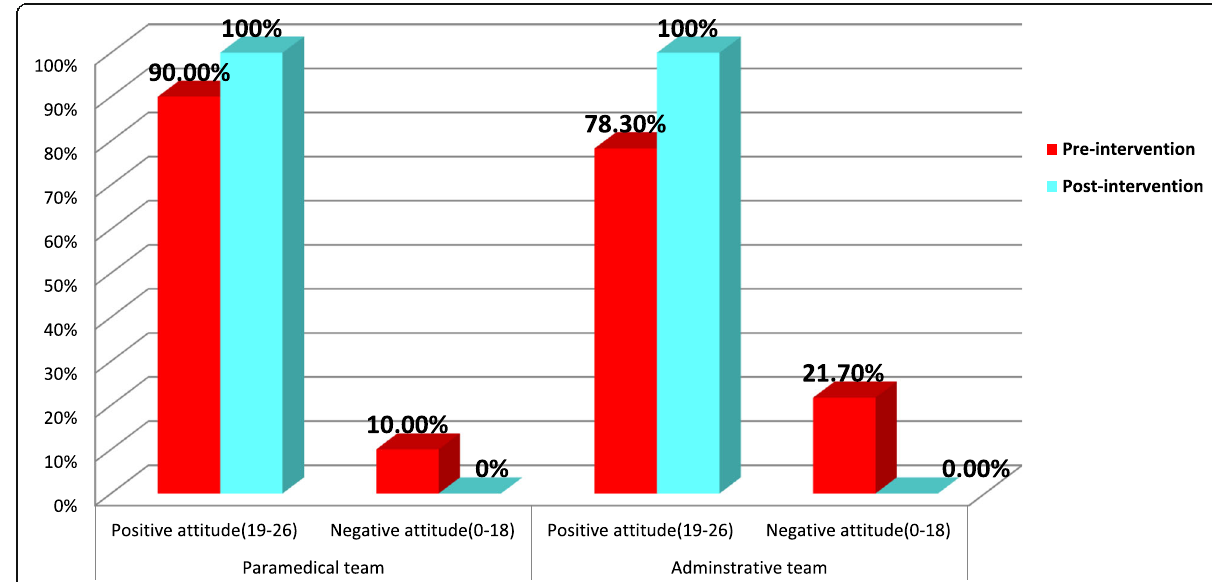
Fig. 2 Effect of education intervention on total attitude scores of paramedical and administrative team participants, pre- and